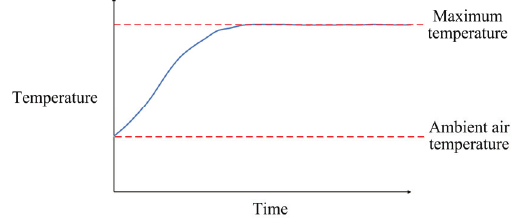
Fig. 3. Illustration of the maximum